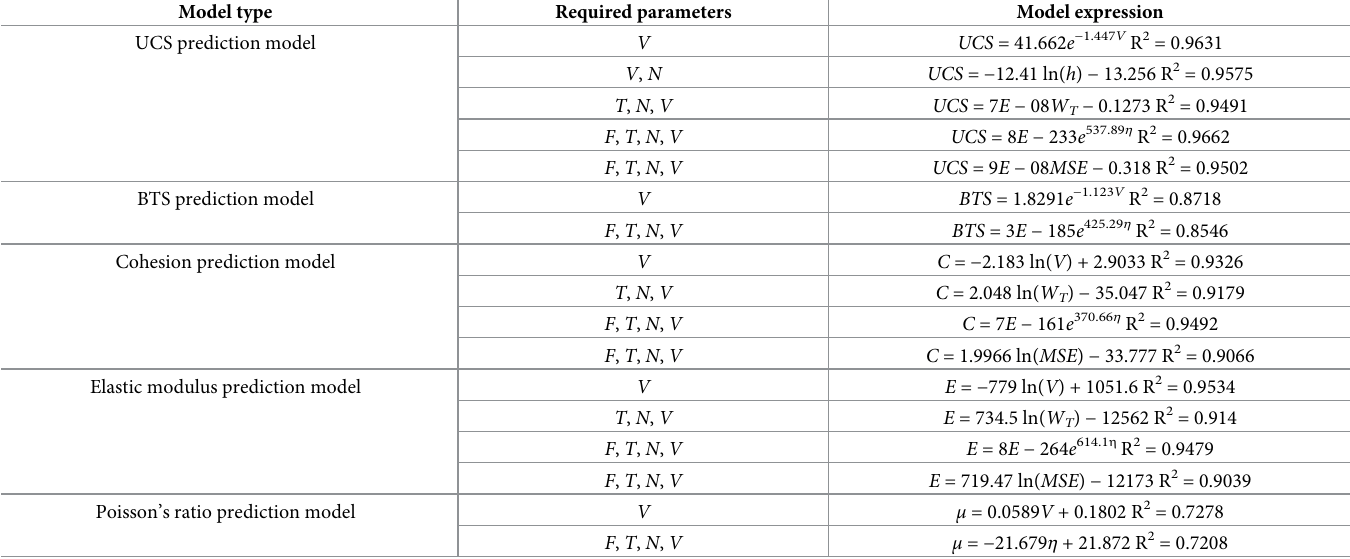
Table 4. The optimal prediction models of rock mechanics